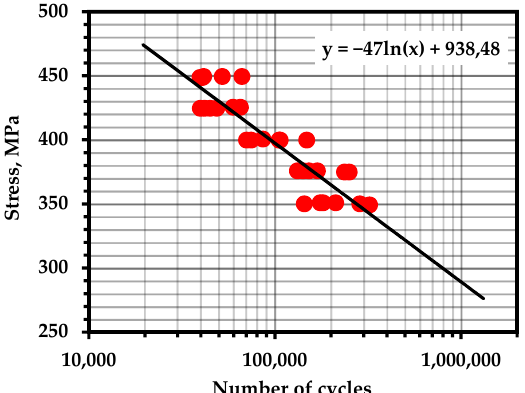
Figure A4. S–N Curve—Ti-15V-3.0Cr-3.0Al-3.0Sn (Temperature—298 K; frequency—20 Hz). Source—Base Total material.